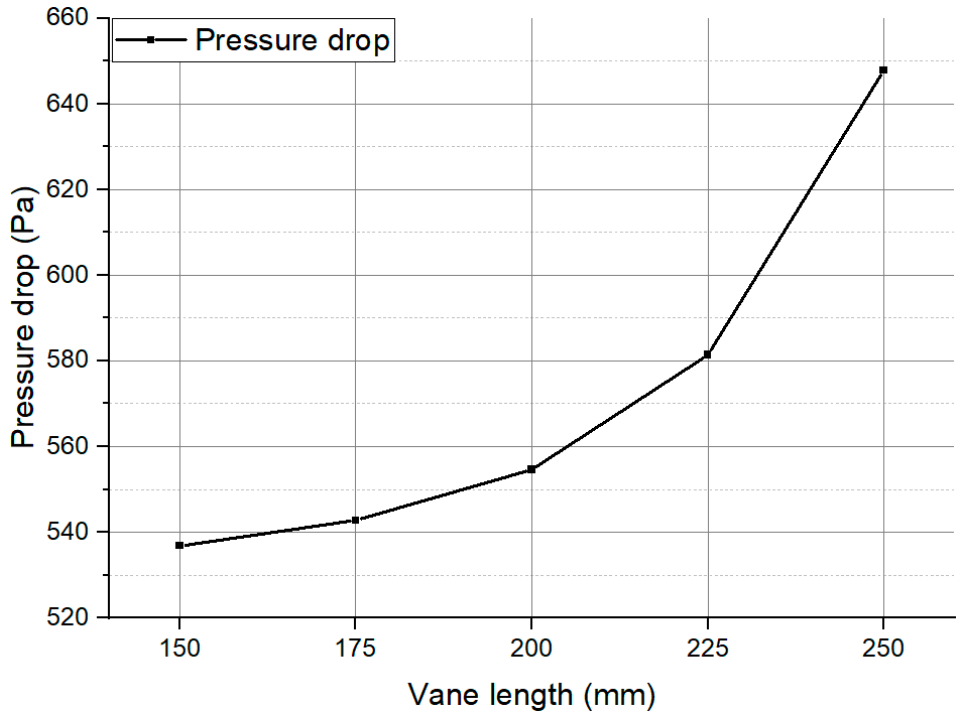
Figure 11. Pressure drop according to the vane length in the inner vane type.